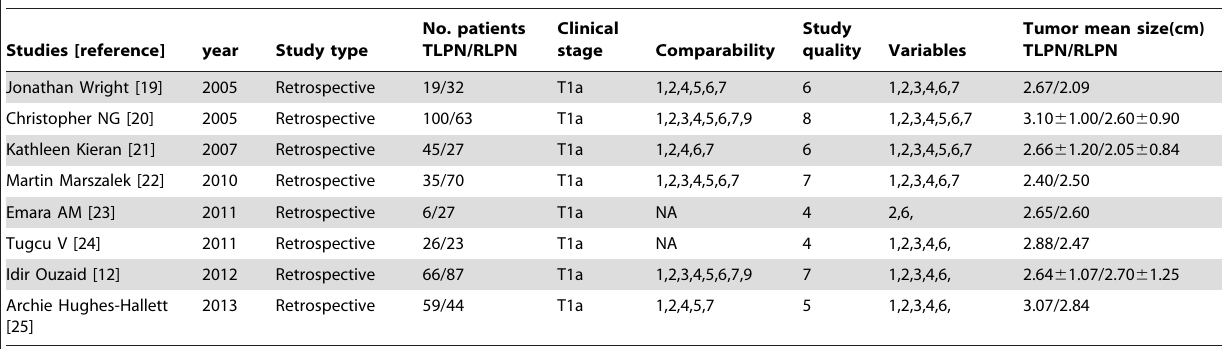
Table 1. Characteristics of included studies.